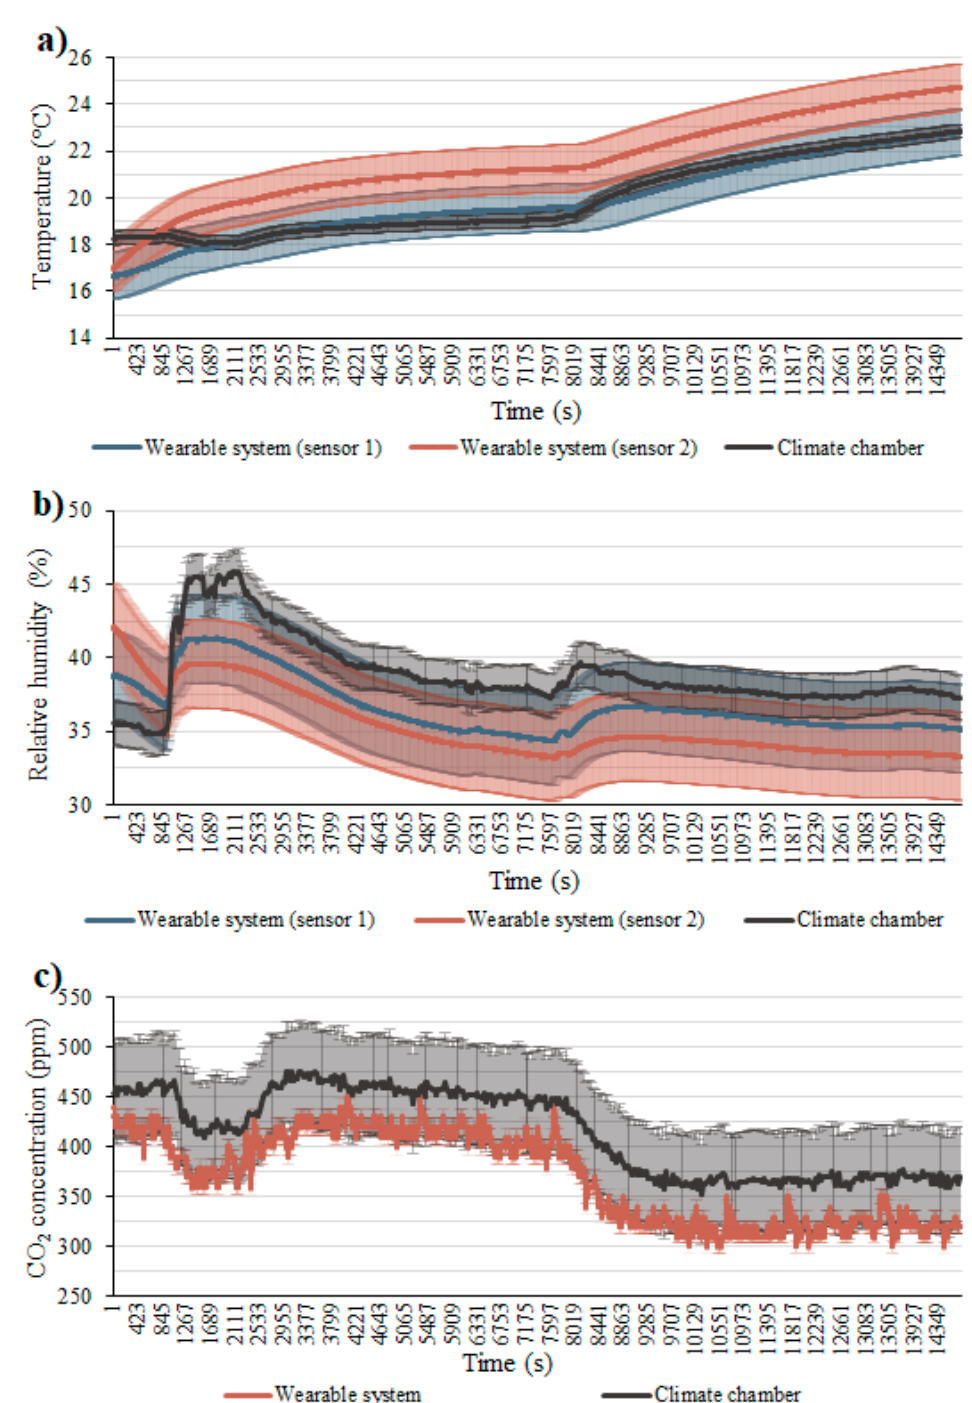
Figure 6. Parameters registered by the developed wearable system and the climate chamber: ( a ) air temperature; ( b ) relative humidity; ( c ) CO 2 concentration. Table 2. Root-mean-square error (RMSE) and coefficient of variation (CV) of the developed weara- ble system parameters compared to those of the reference systems.